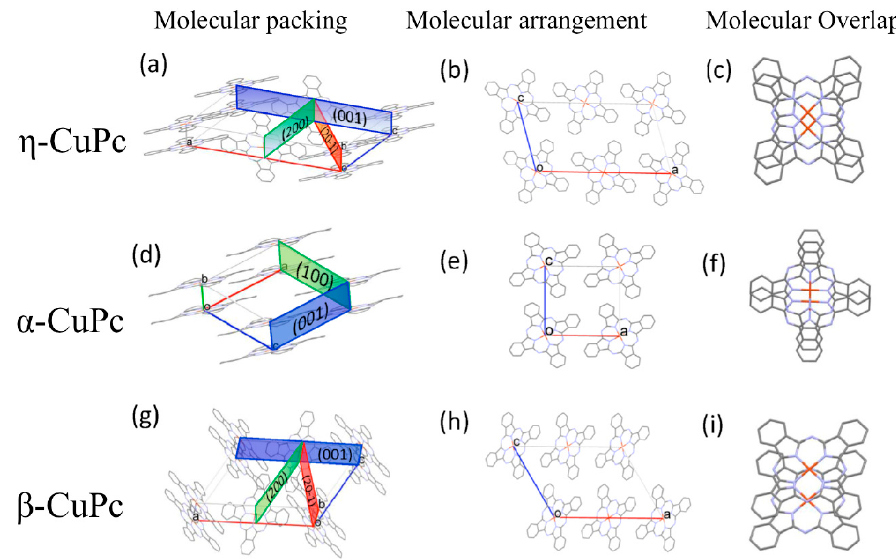
Figure 3 . Schematic packings of CuPc molecules into the η , α , and β -phase is shown in ( a , d , g ) respectively. Molecular arrangement schemes of them are shown in ( b , e , h ) respectively, as seen along [010]. CuPc molecule overlap types are shown in ( c , f , i ) respectively.